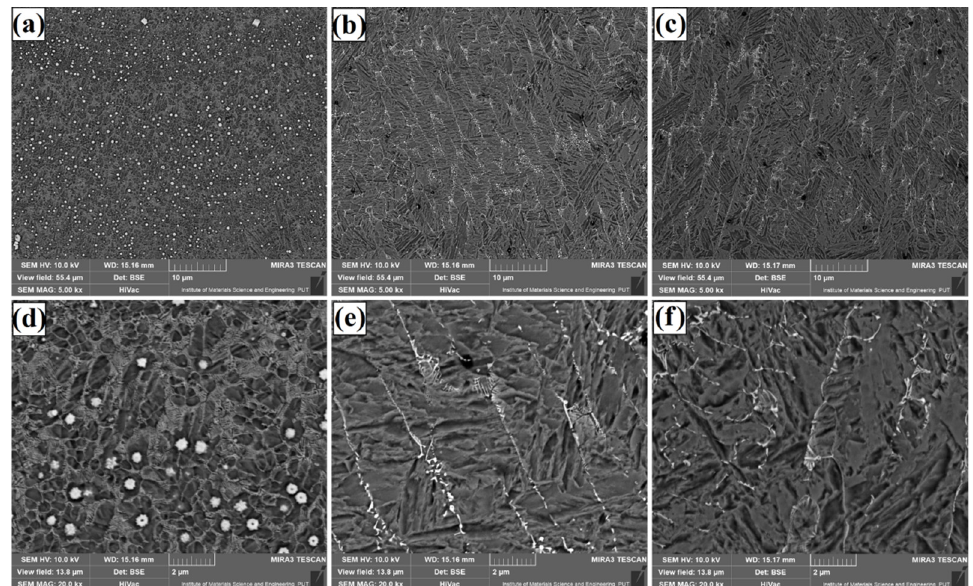
Figure 12. Near-substrate area of the Fe/TaC coatings produced on tool steel using 30 µm thick pre-coat and laser beam power of 500 W ( a , d ), 800 W ( b , e ), 1100 W ( c , f ).